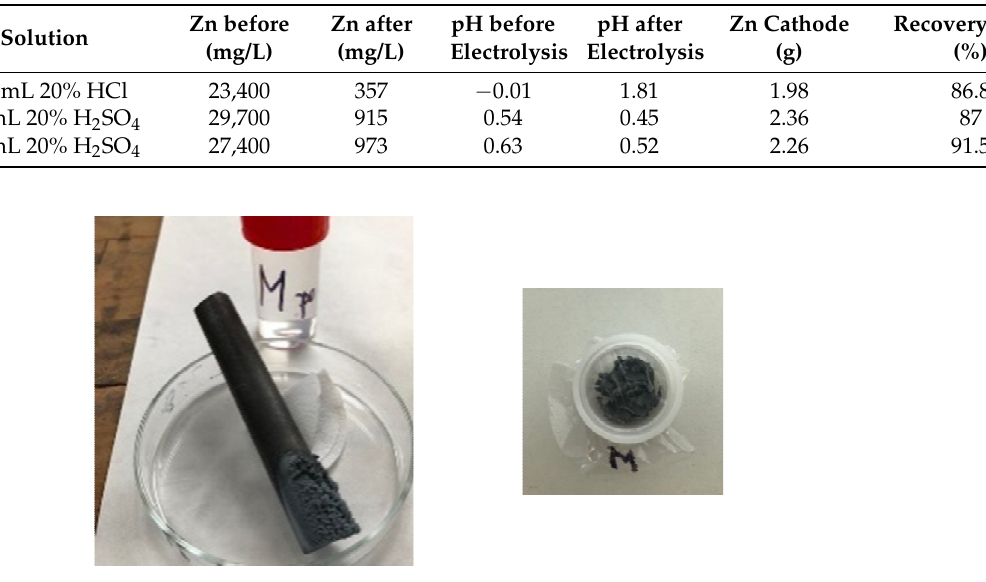
Figure 7. Segregated zinc on the graphite cathode (the electrolyte: HCl solution) on the left side—sample M (see Table 12). Cathode zinc in the flask for ED-XRF analysis. Source: own. Table 12. AAS analysis results—a condition after dissolving in acids and after the electrolysis.